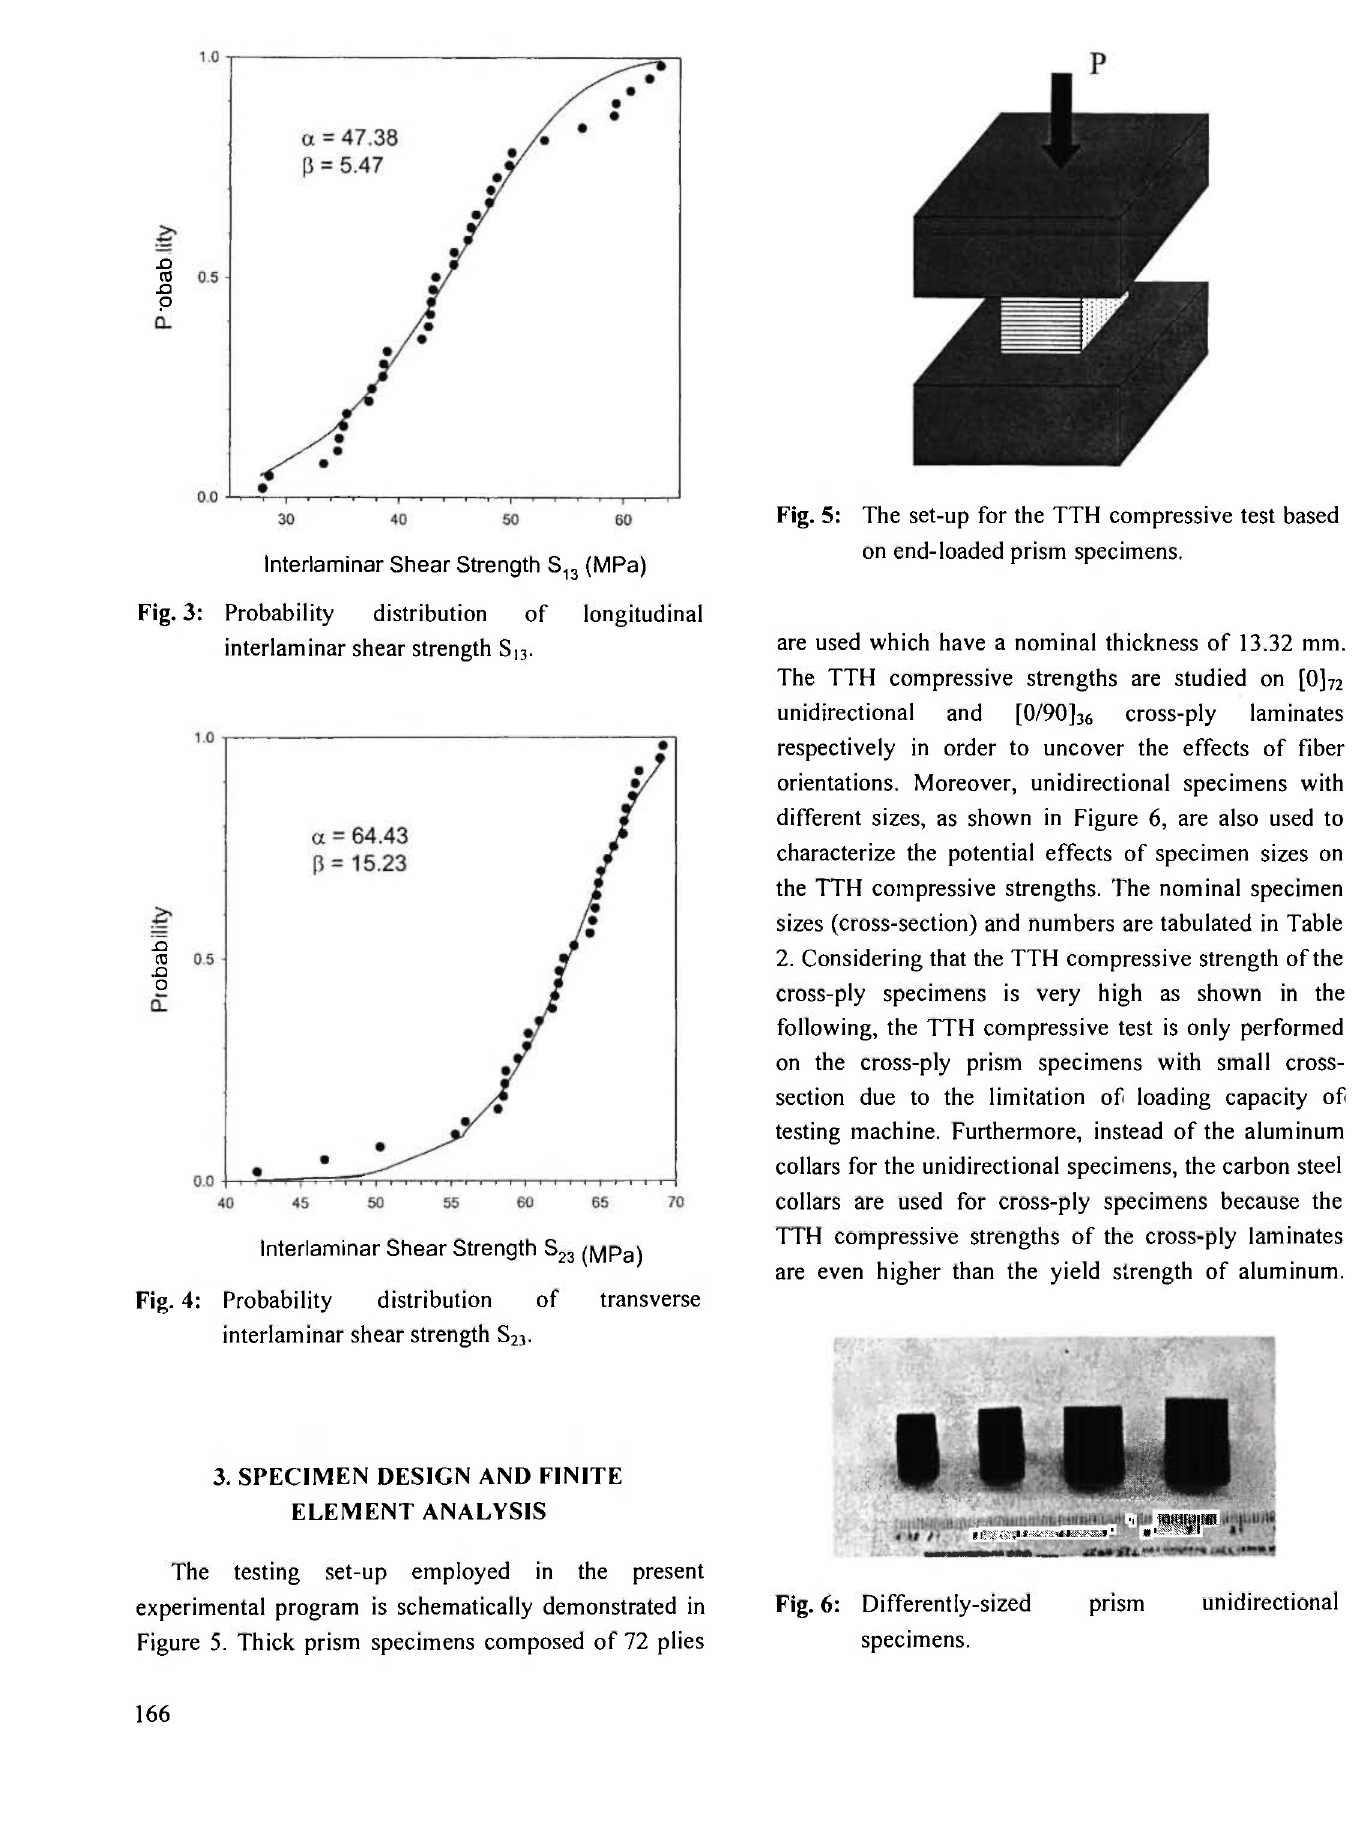
Figure 5. Thick prism specimens composed of 72 plies